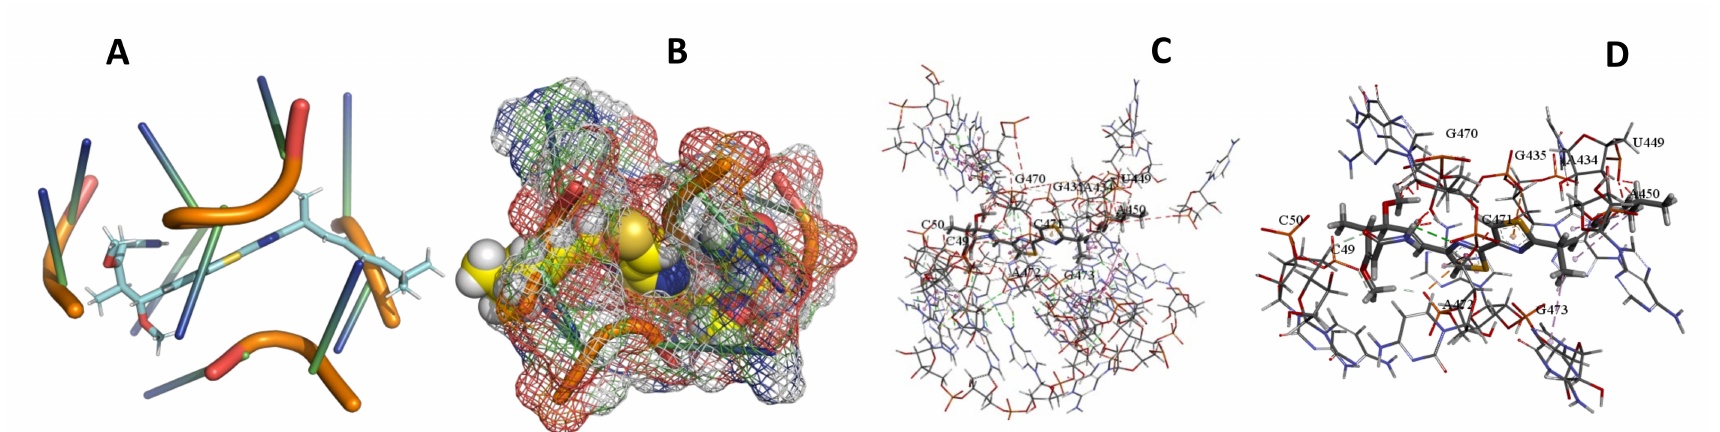
Figure 26. T. Cruzi + Myxothiazol. ( A ): Best binding pose and nucleotides involved. ( B ): Schematic binding pocket. ( C ): shows the Nucleotides component that re involved in binding. ( D ): Shows the main bonds involved between the compound and the nucleotide component.